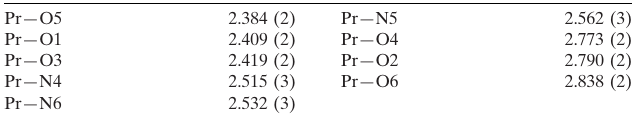
Selected bond lengths (A˚